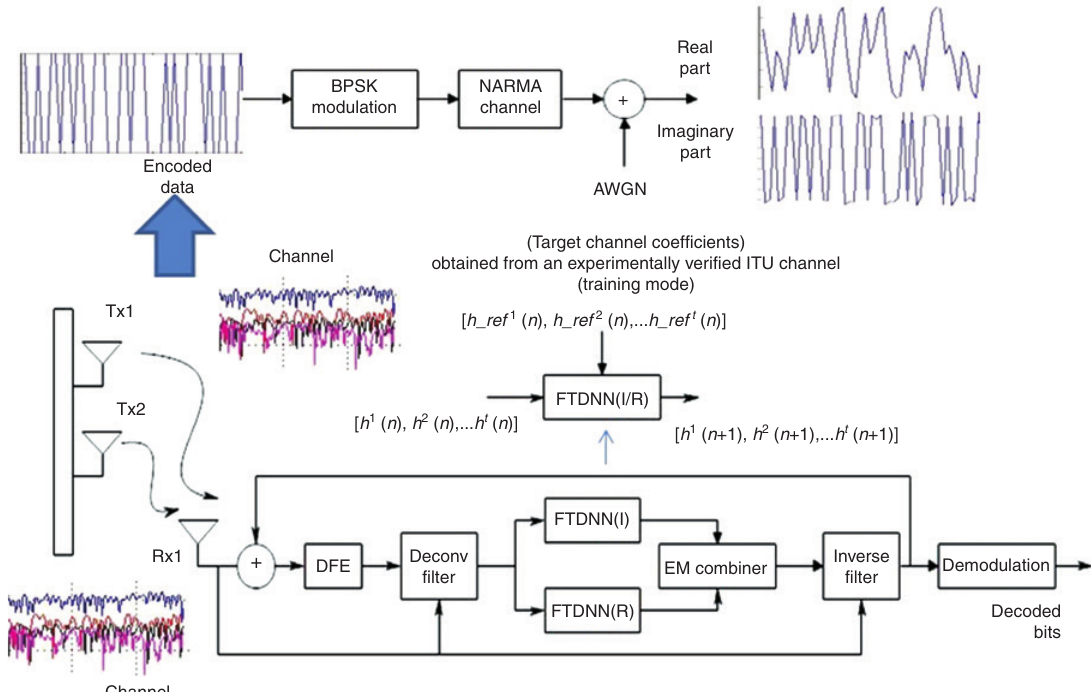
Figure 4: Proposed Split FTDNN Channel